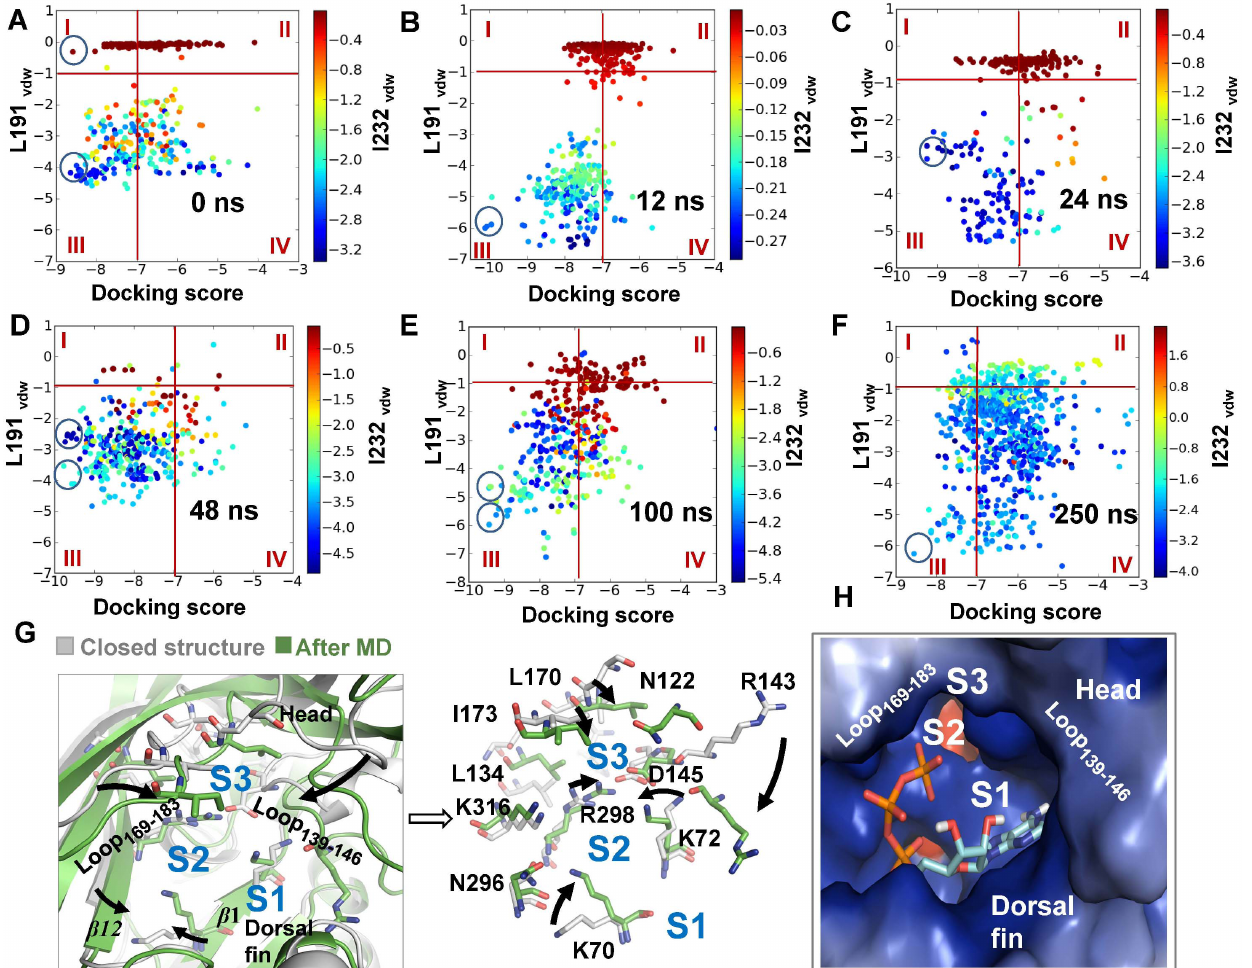
Figure 4. Molecular docking of ATP into various sampled conformations of zf P2 X 4 . ( A–F ) Summary of poses in various sampled conformations of zfP2 X 4. These conformations were sampled from snapshots of MD simulations, during which downward motion of head domain occurred. In this panel and Figure 6B, the poses distributed into region I and III represent rational recognition modes of ATP, AR2/3 and AR1, respectively. The docking scores and vdW scores of L191 and I232 of per poses were calculated by Glide [34]. Each dot represents a pose of ATP. The colors of dot indicate the vdW scores of I232. Blue dot means strong vdW contacts between ATP and I232. The top poses of each sampled conformation of receptors were highlighted within black cycles. ( G ) Superposition of the initial structure (grey) and equilibrated representative structure (green) after 300-ns MD simulations. Black arrows denote the movements of key domains/regions and residues (displayed in sticks for emphasis) from the initial structure to equilibrated structure. ( H ) 3-D architectures of ABP with docked-ATP in the equilibrated representative structure of zfP2 X 4 after MD simulations. S1, S2 and S3 indicate three potential sites interacting with the adenine ring of ATP.